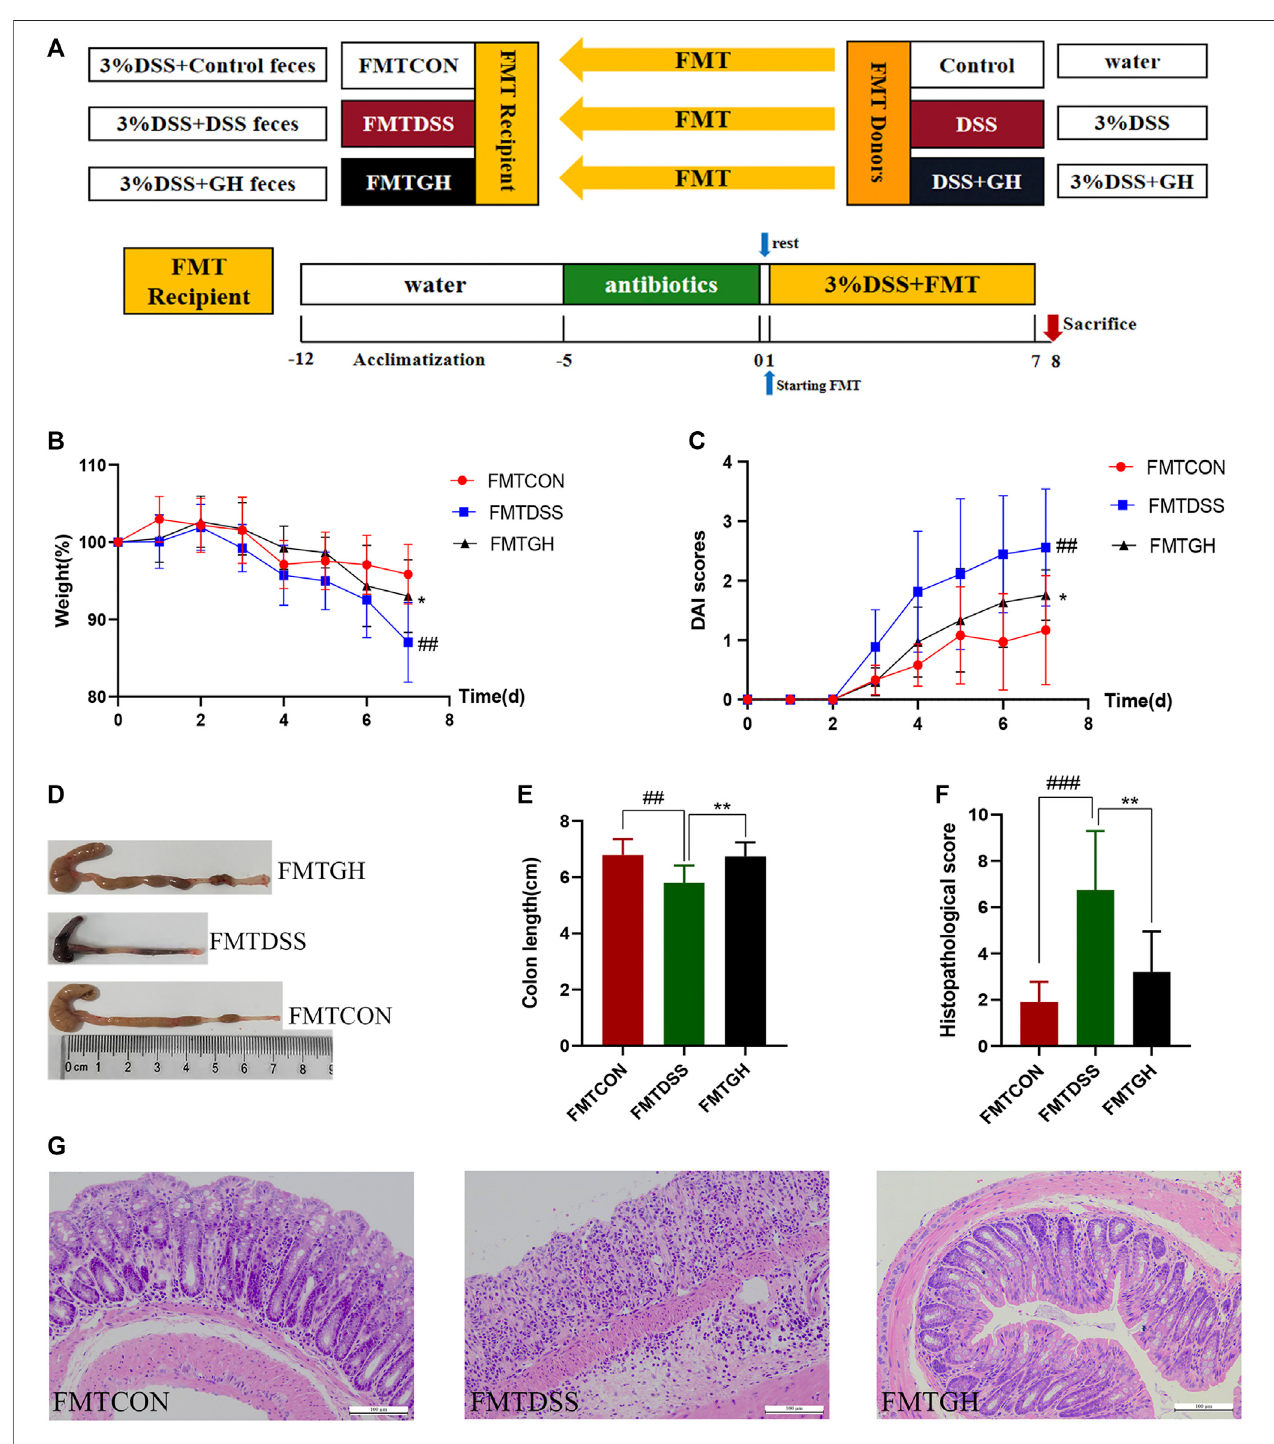
FIGURE 3 | Transplantation of MGQD-altered gut microbiota recapitulated the effects of MGQD treatment on DSS-induced colitis. (A) Experimental design. (B) Bodyweight change. (C) DAI score. (D) Representative photograph ofcolons. (E) Statisticsofcolon length. (F) The histological scoresof mouse colon morphology. (G) Histological changes of the colon based on HE staining (magni fi cation, × 200). Data were expressed as mean ± SD (n (cid:2) 8 – 10). ## p < 0.01, ### p < 0.001, vs FMTCON group; * p < 0.05, ** p < 0.01, vs FMTDSS group.